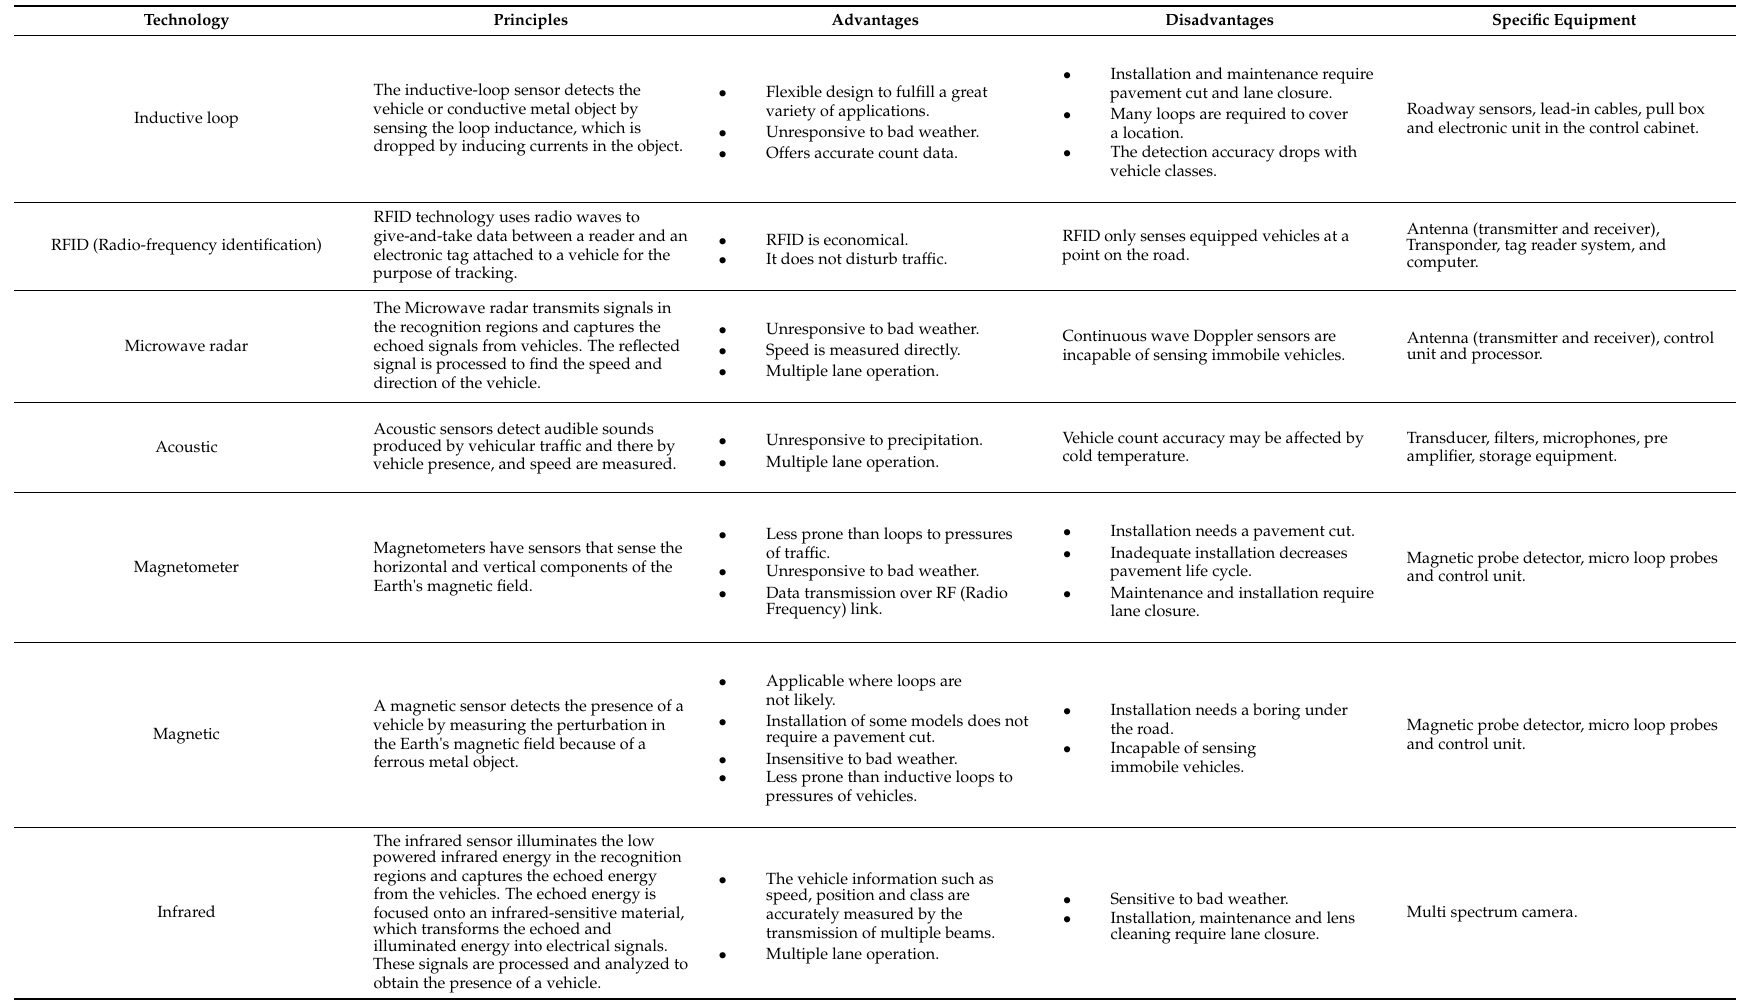
Table 1. Overview of traffic sensing technologies